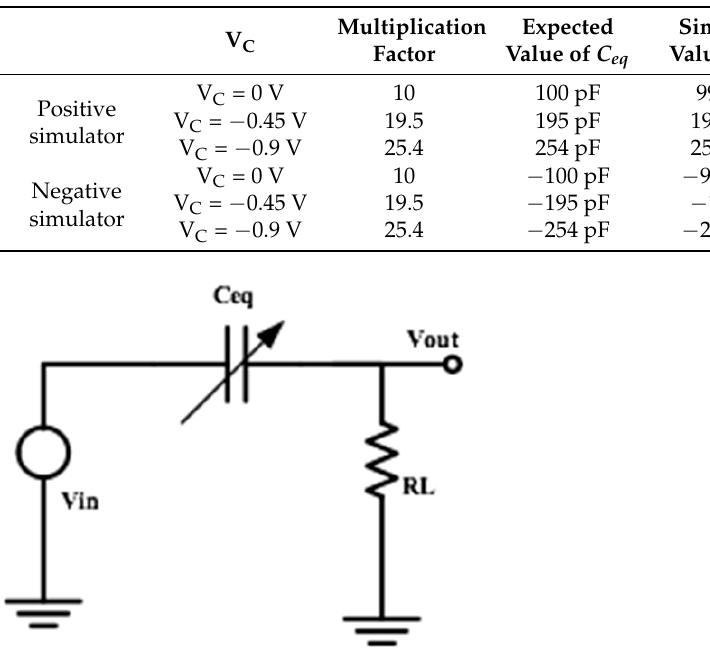
Figure 8. Frequency response of magnitude (blue) and phase (red) for the proposed ( a ) positive and ( b ) negative floating capacitor simulator. Table 3. Deviation between theoretical and simulated values at different multiplication factors, C = 10 pF and f = 100 kHz.